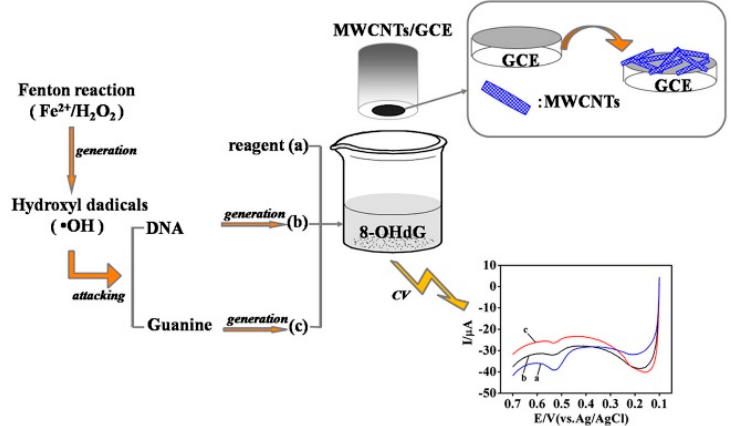
Figure 2. Glassy carbon electrode (GCE) / multi-walled carbon nanotubes (MWCNT) sensor for the determination of o 8 dGuo. Reprinted with permission from Reference [28]. © 2016,